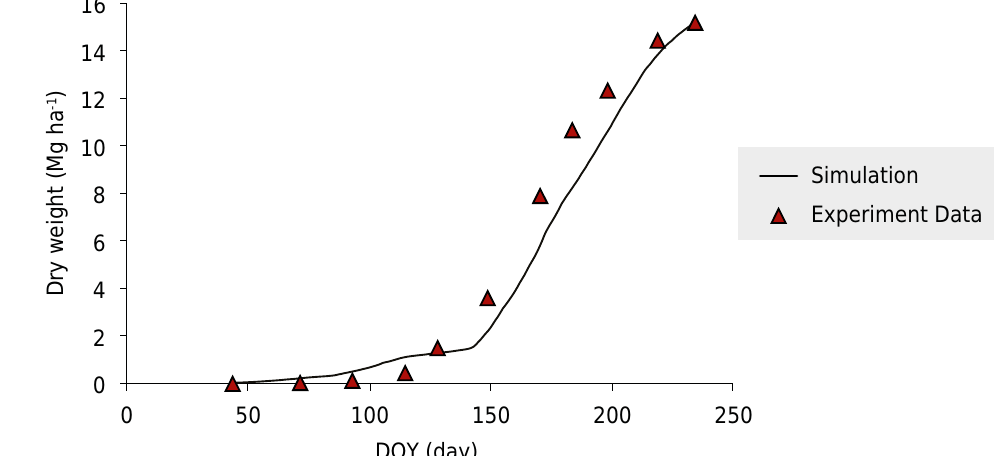
Figure 6. Comparison of dry weight with time between measurement and